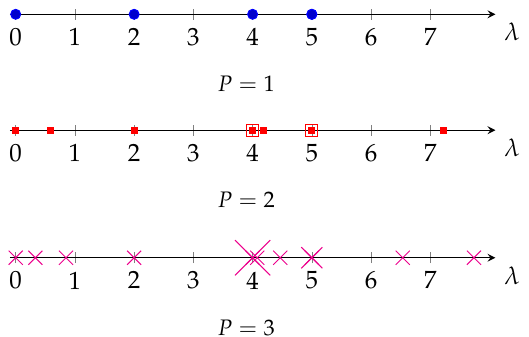
Figure 6. Eigenvalues of L P for the graph in Figure 2b for P = { 1,2,3 } .